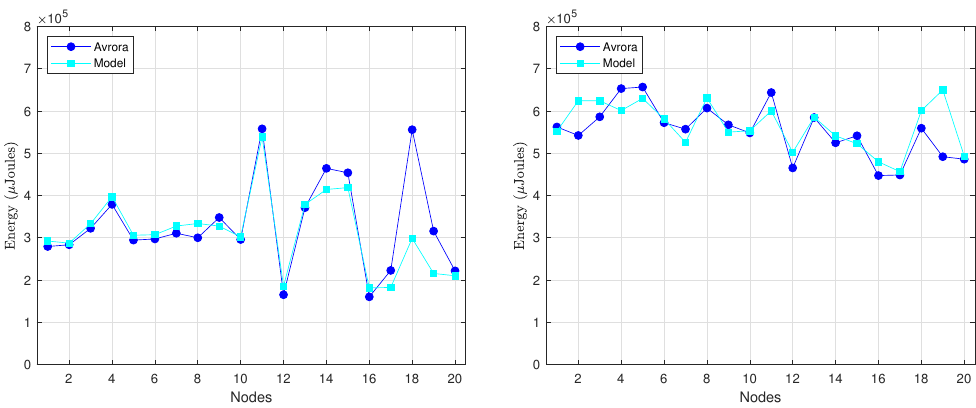
Figure 14. Avrora vs. energy model comparison for the 20-nodes network with DC = 3% ( left ) and DC = 10% ( right